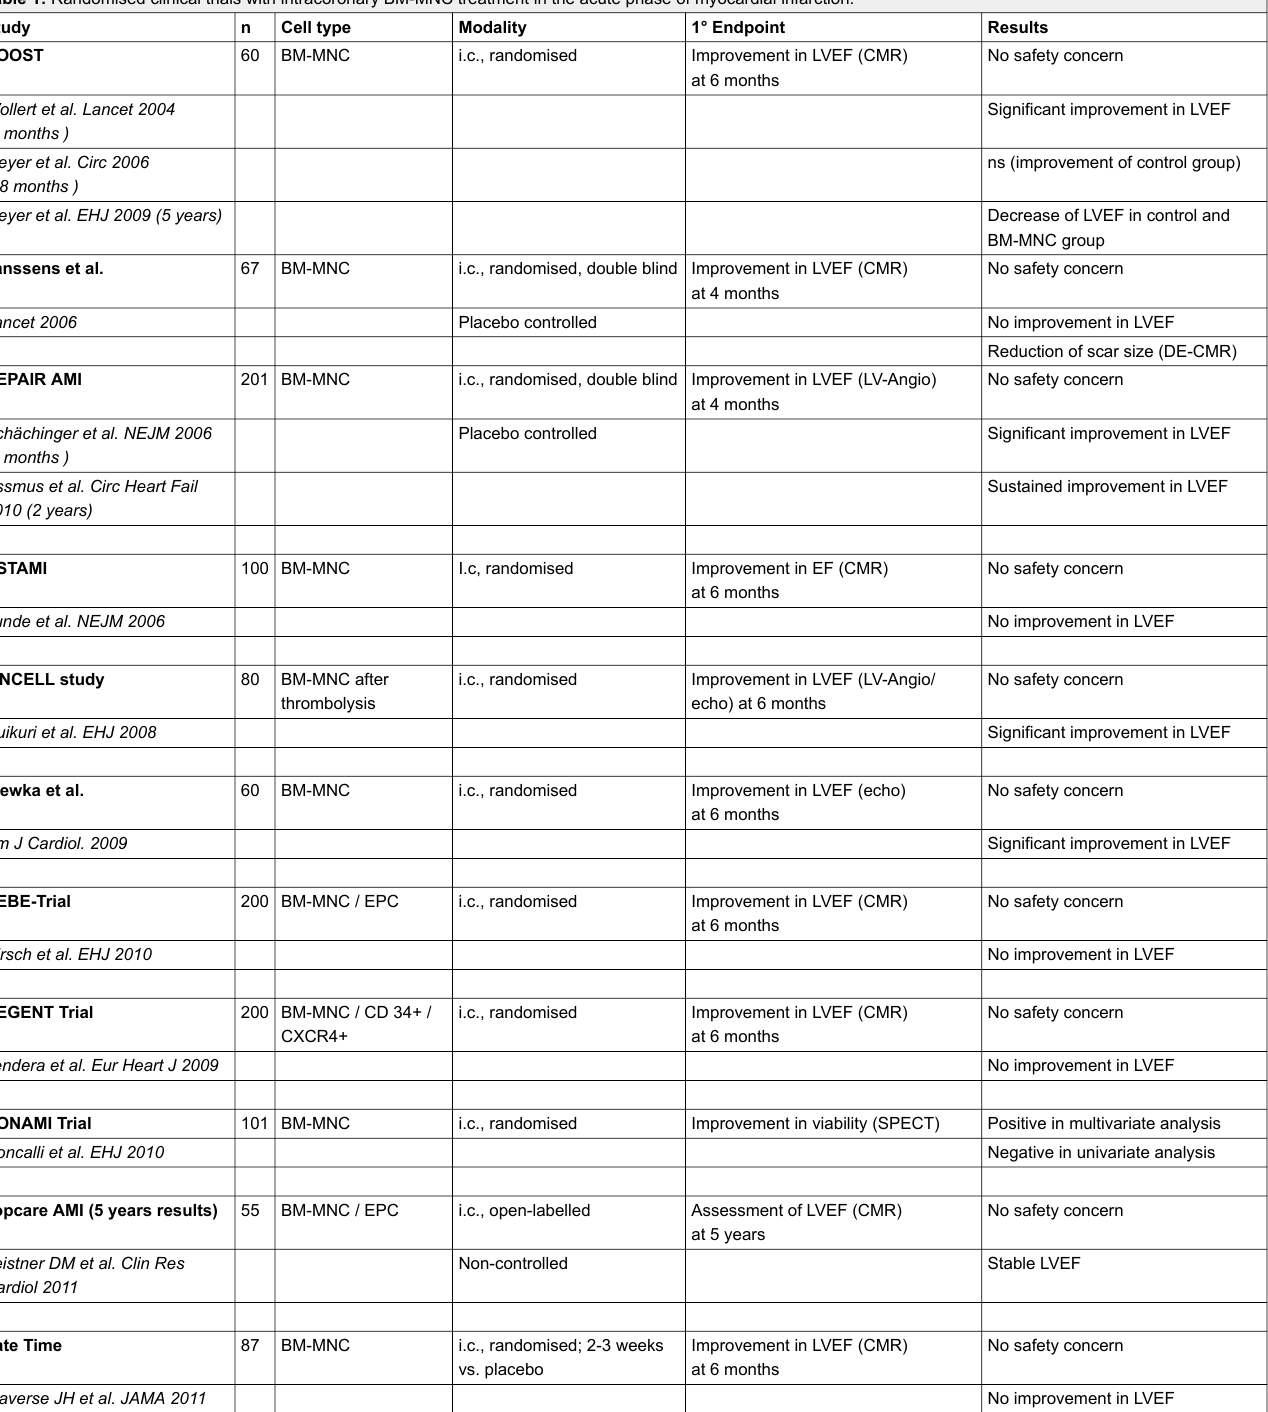
Table 1: Randomised clinical trials with intracoronary BM-MNC treatment in the acute phase of myocardial infarction. Study